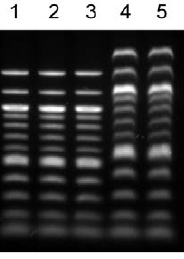
Figure 7. The non-DNA-intercalating property of candesartan cilexetil. Candesartan cilexetil or ethidium bromide was incubated with double-stranded DNA ladder, and the reaction products were run on 1% agarose gel and stained with ethidium bromide. Lane 1: No compound. Lane 2: 0.75 nmol of candesartan cilexetil was incubated with 1.5 nmol DNA. Lane 3: 3 nmol of candesartan cilexetil was incubated with 1.5 nmol DNA. Lane 4: 0.75 nmol of ethidium bromide was incubated with 1.5 nmol DNA. Lane 5: 3 nmol of ethidium bromide was incubated with 1.5 nmol DNA.